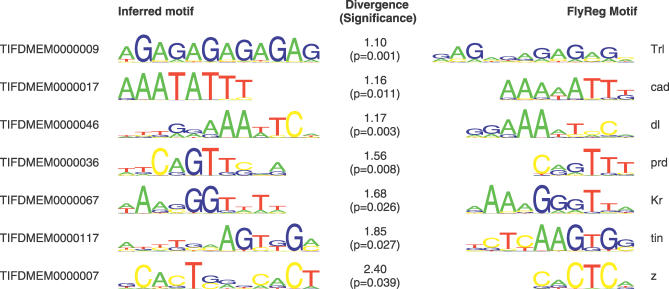
Statistically Significant Best Reciprocal Matches between 120 Discovered Motifs and Motifs Inferred from Drosophila DNase I Footprint Data